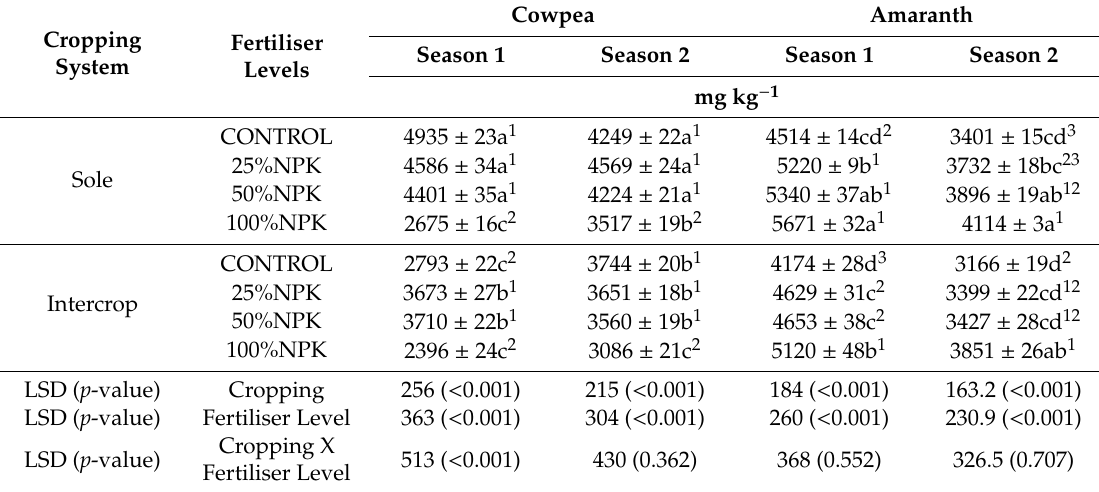
Table 4. Plant phosphorus concentration in cowpea and amaranth fertilized with four levels of NPK in 2014 / 15 (season 1) and 2015 / 16 (season 2) seasons.